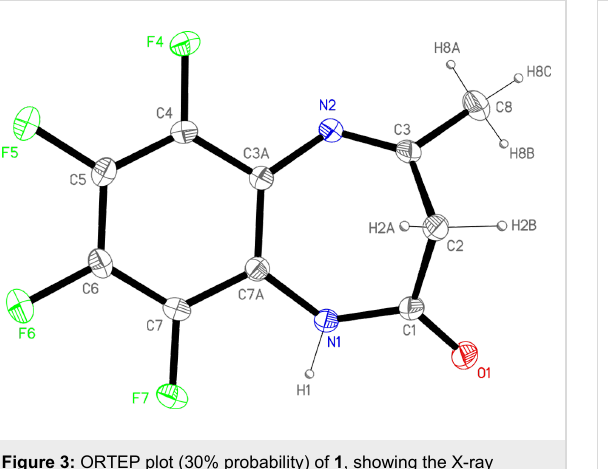
Figure 3: ORTEP plot (30% probability) of 1 , showing the X-ray labeling of the asymmetric unit. Compound 2 crystallizes in the triclinic P –1 space group containing one molecule per asymmetric unit (Figure 5). As for compound 1 , the molecular geometry corresponds to tautomer a . The seven-membered ring is also folded with dihedral angles between the aromatic ring and C1N1O1 of 44.1(3)º and with N2C3C8 of 43.2(3)º. This higher values compared to com- pound 1 indicate a greater deformation in the seven-membered ring owing to the presence of the N -methyl substituent. The N -methylation prevents the dimerization by hydrogen bonding leading to a very different packing. Therefore, the most significant intermolecular interaction is the F–F contact between the F4 and F7 atoms of adjacent molecules (distance 2.669(3) Å) giving rise to chains along the b axis (Figure 6). Each chain is placed antiparallel to the following one in order to minimize the steric hindrance of the groups out of plane. The two chains interact by π – π overlapping between their aromatic